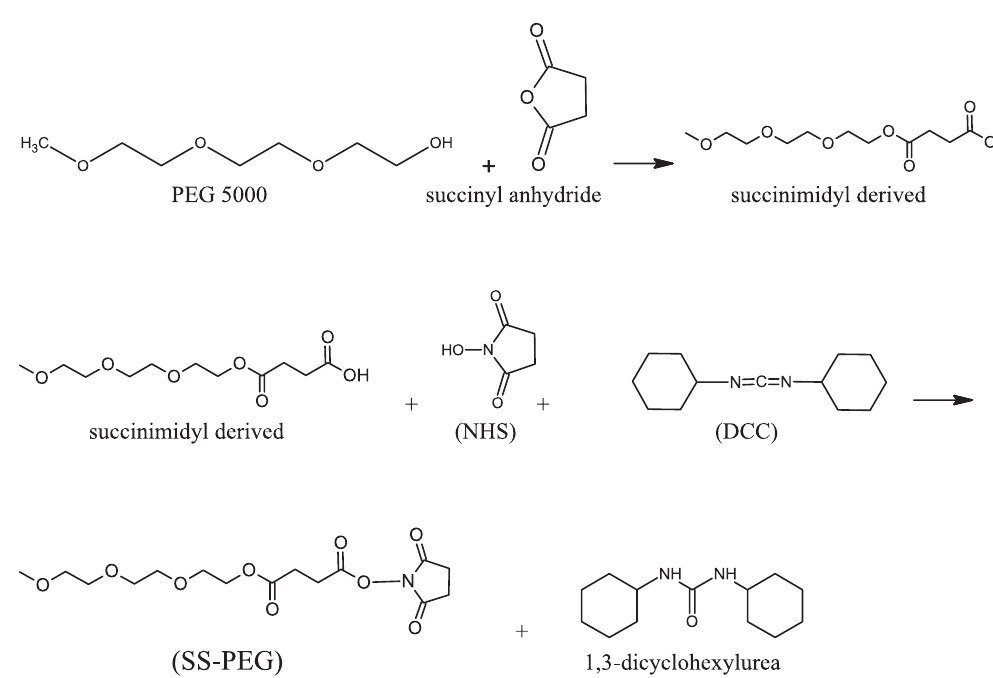
SCHEME 1 - Obtention of the PEG activated derivative, used to modify the papain.